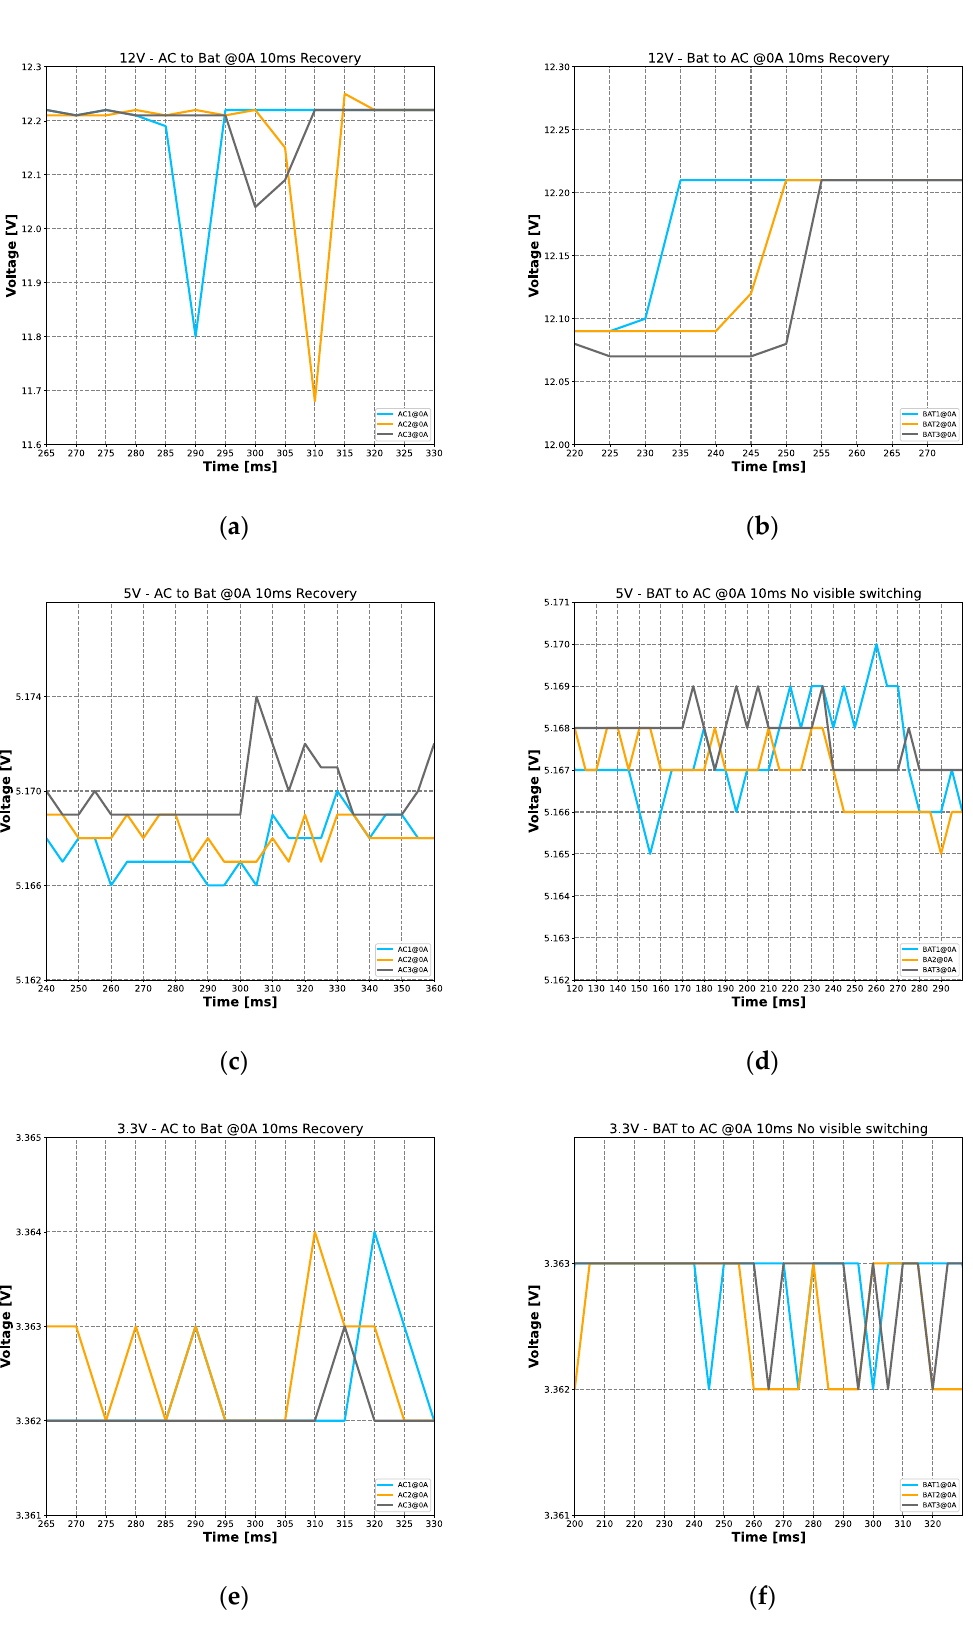
Figure 12. Graph showing all the switching between sources: ( a ) Switching between AC and battery on 12 V with 0 A, ( b ) Switching between battery and AC on 12 V with 0 A, ( c ) Switching between AC and battery on 5 V with 0 A, ( d ) Switching between battery and AC on 5 V with 0 A, ( e ) Switching between AC and battery on 3.3 V with 0 A, ( f ) Switching between battery and AC on 3.3 V with 0 A.